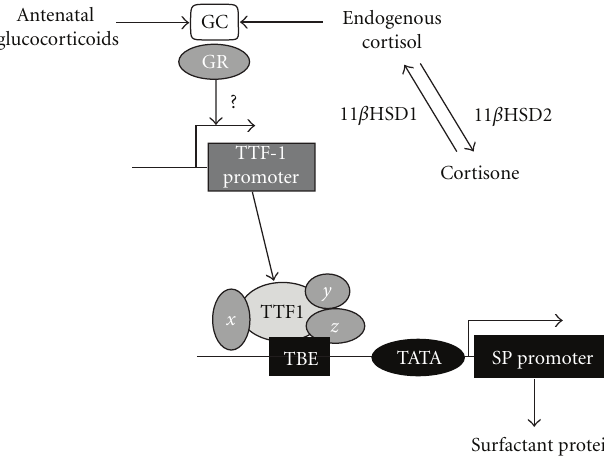
Figure 3: Diagrammatic representation of the mechanism by which endogenous (circulating or locally produced) cortisol and antenatal glucocorticoids act in the lung to increase the gene and protein expression of surfactant protein. GC: glucocorticoid; GR: GC, receptor; TTF-1: thyroid transcription factor-1; TBE: TTF-1 binding element; x , y , and z indicate cofactors for di ff erent SP